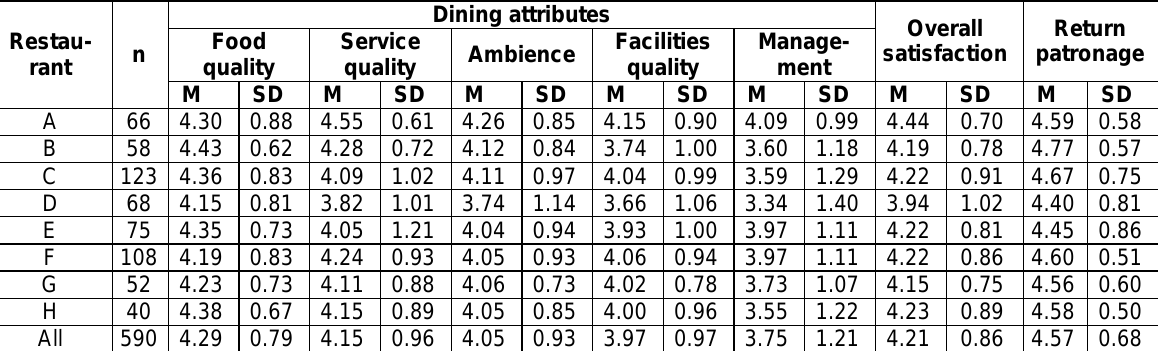
Table 5: Means and standard deviations for the five dining attributes, overall dining satisfaction and return patronage in the respective mall